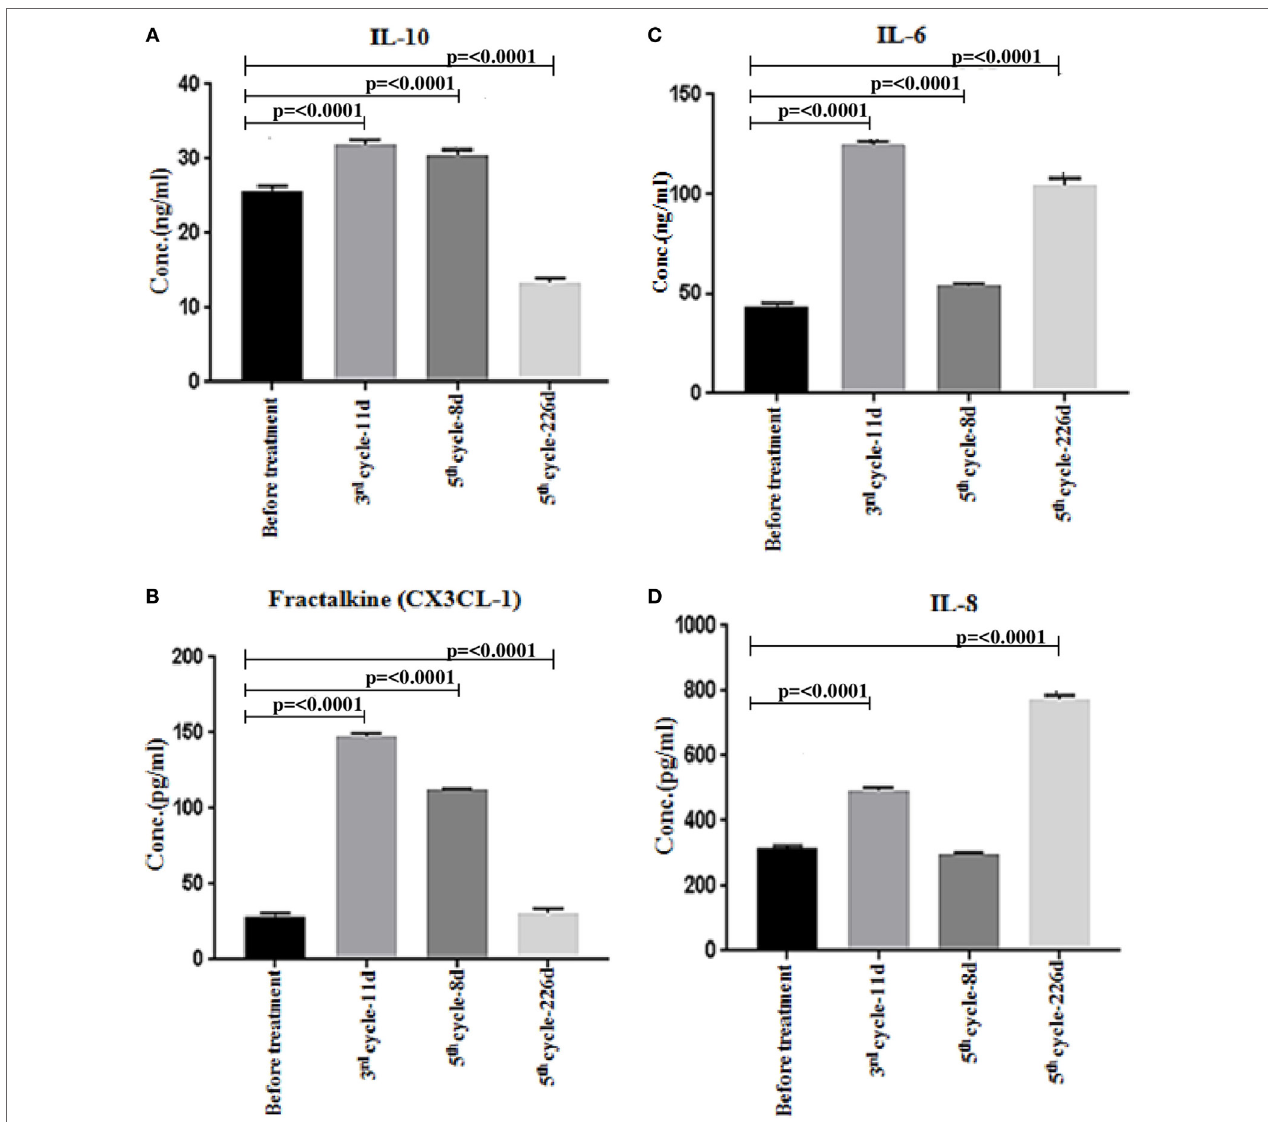
FIgURe 4 | Multiplex analysis of cytokines/chemokines in patient plasma before and after nivolumab treatment, and after progression. (a,B) Significant downregulation of the immune activation biomarkers (IL-10 and CX3CL-1 also known as Fractalkine) at progression (fifth cycle-226 days). (C,D) Significant upregulation of the immune inhibition biomarkers (IL-6 and IL-8) at progression (fifth cycle-226 days). The assay was repeated three times and the shown data corresponds to one representative experiment. Statistical analysis was performed using non-parametric unpaired ANOVA followed by multiple comparison Dunnet’s test and p values < 0.05 were considered statistically